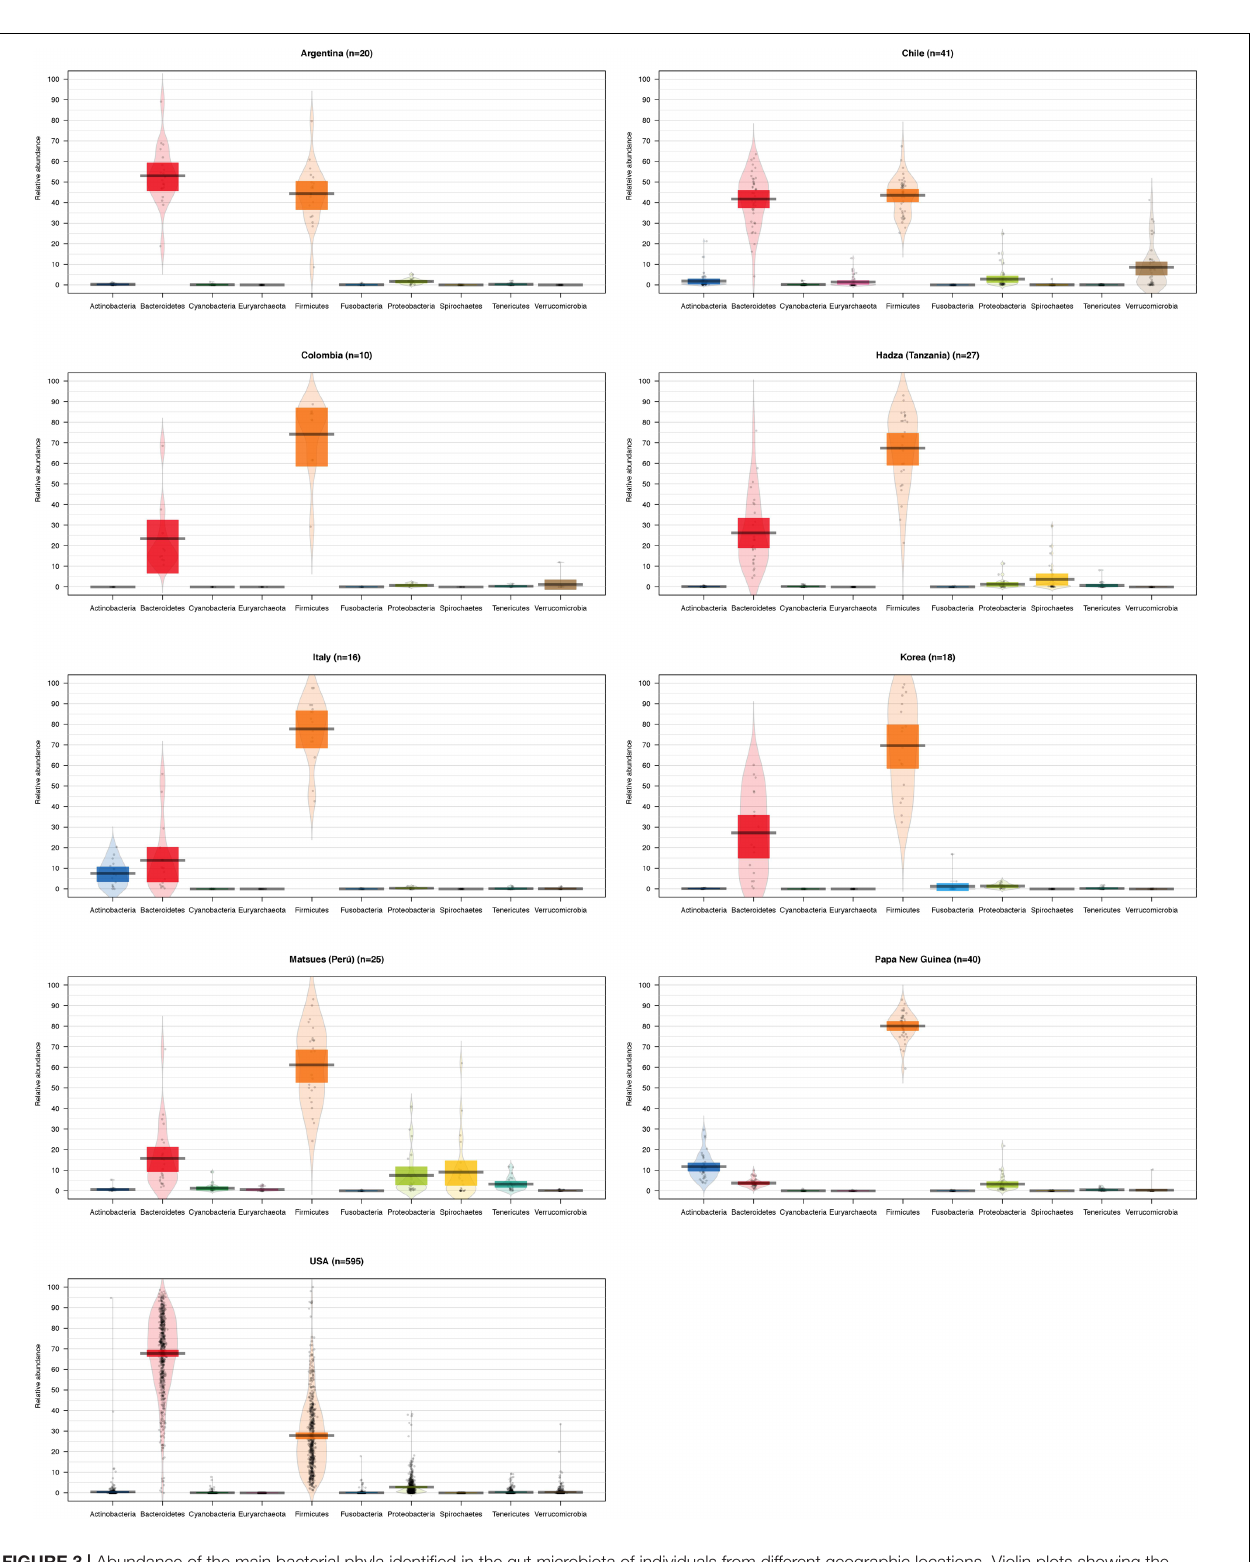
FIGURE 3 | Abundance of the main bacterial phyla identified in the gut microbiota of individuals from different geographic locations. Violin plots showing the abundance of the most abundant bacterial phyla for the gut microbiota of different populations. The number of subjects for each population is shown on the title, and each bar represents a different bacterial phylum. The black line indicates the median of the values, the colored box the interquartile range and the area in light color corresponds to the distribution of the data.